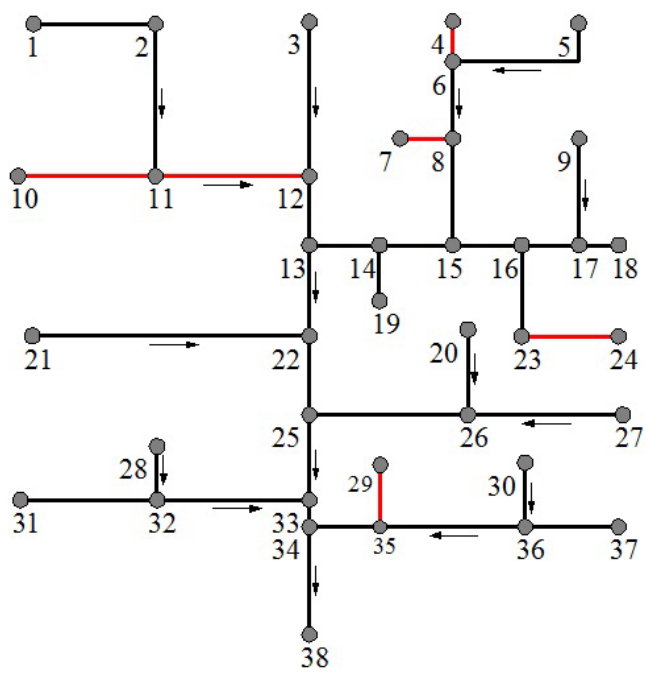
Figure 4. Biggiero and Pianese (1996) [64] vs. case BP-2A. Layout.